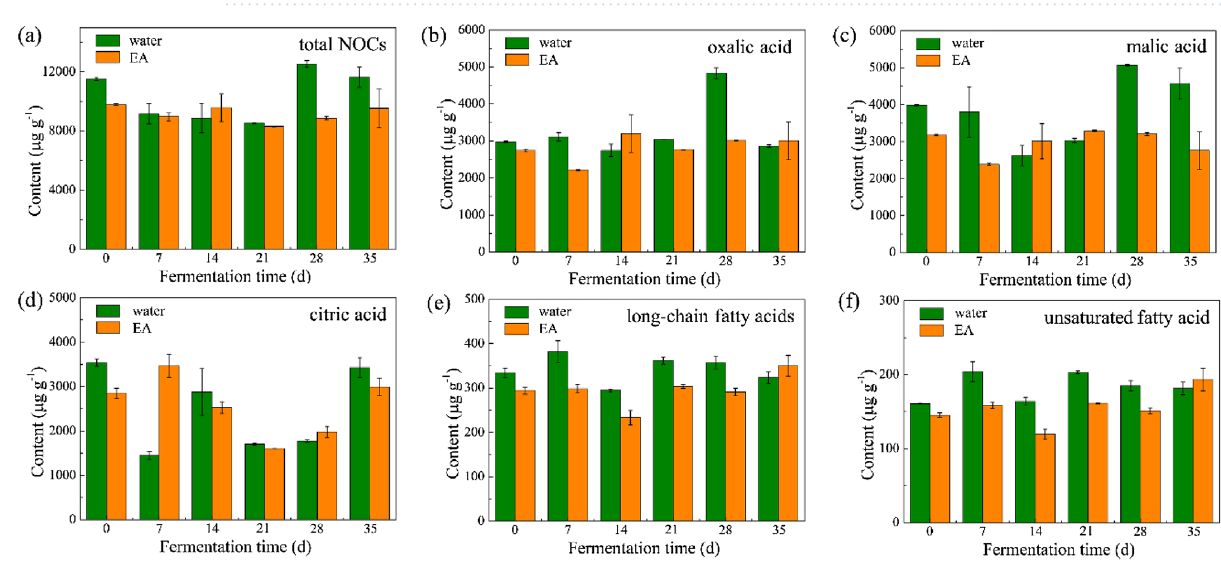
Figure 3. Contents of total NOCs ( a ), oxalic acid ( b ), malic acid ( c ), citric acid ( d ), long-chain fatty acids ( e ), and unsaturated fatty acid ( f ) of CTL samples in water- and